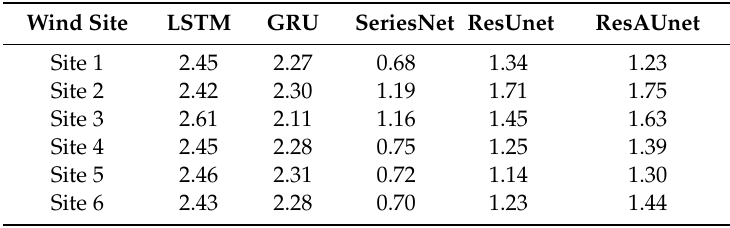
Table 10. Average training time for each training window (in